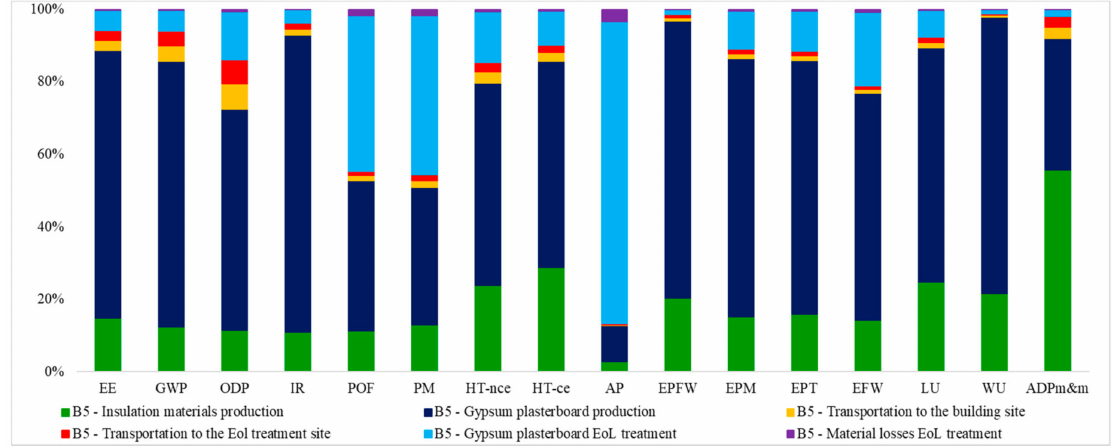
Figure A2. Contribution of the different life cycle phases to the B5 module impacts—CfS (1990–2010). Figures A3 and A4 illustrate the contribution analysis results of the different life cycle phases to the B5 module impacts in the case of buildings realized between 1970 and 1989 and between 1990 and 2010 in SwS, respectively.